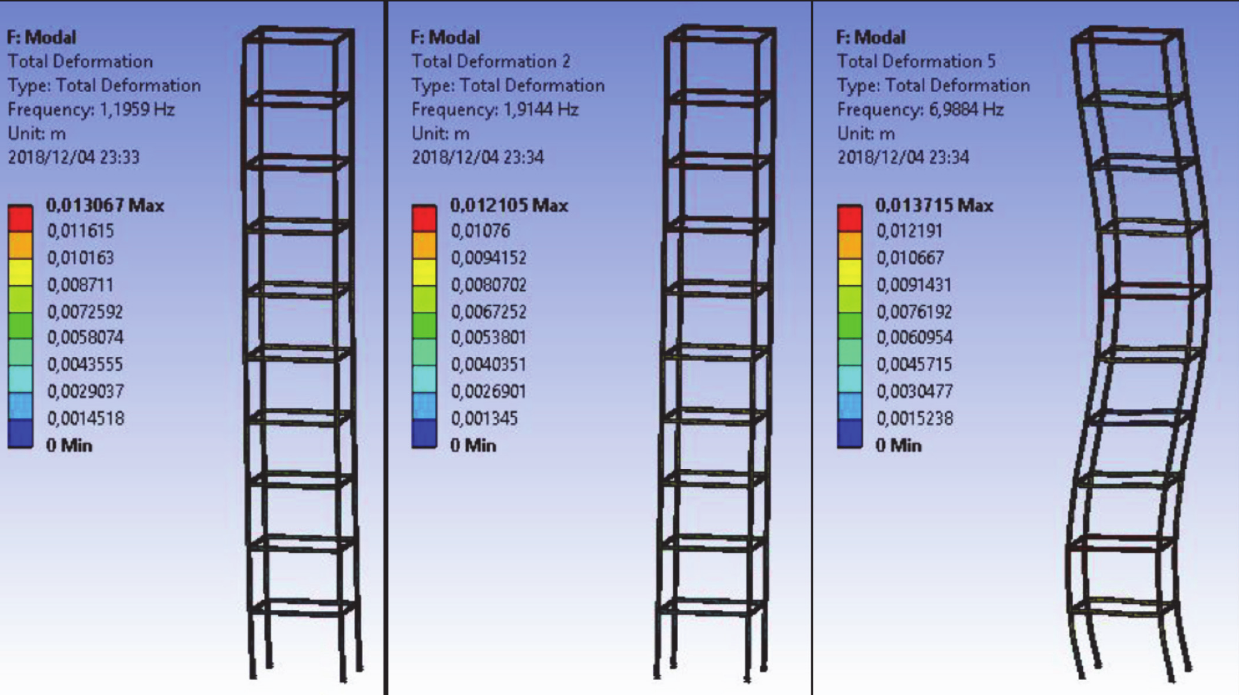
Figure 9: Mode Shapes 1, 2 and 5 of the LRB